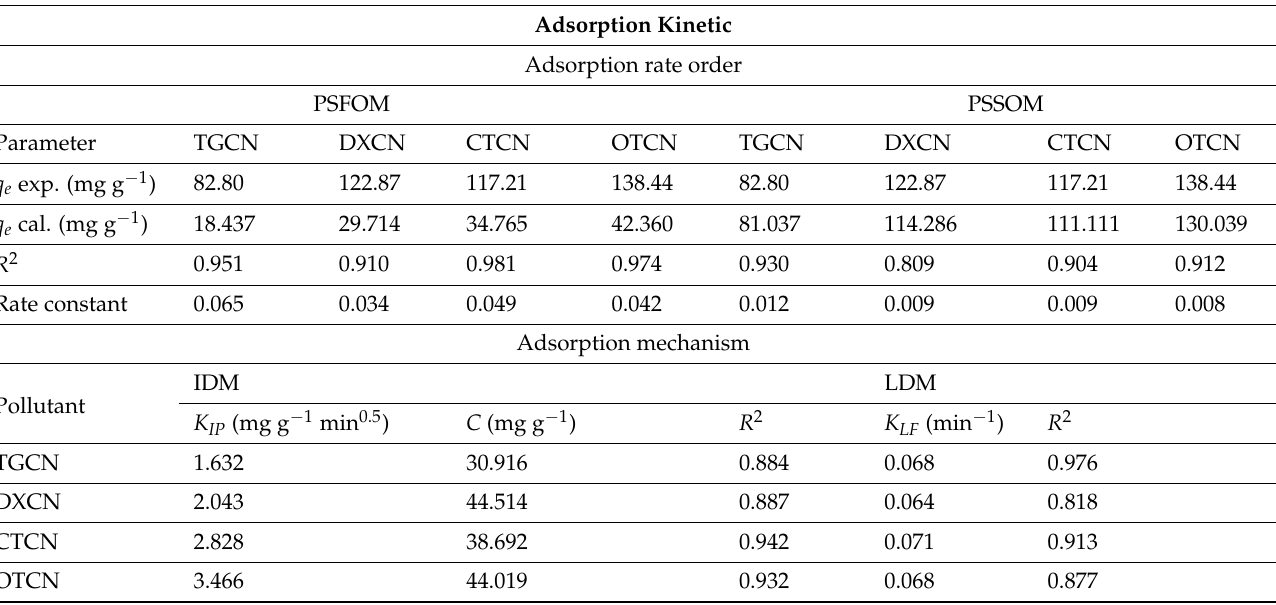
Figure 6. ( a ) PSFOM, ( b ) PSSOM ( c ) LFD, ( d ) IPD investigations for the adsorption of TGCN, DXCN, Figure 6. (a) PSFOM, (b) PSSOM (c) LFD, (d) IPD investigations for the adsorption of TGCN, DXCN, CTCN, and OTCN on the synthesized CRNPs from 100 mg L − 1 solutions at 25 ◦ C. CTCN, and OTCN on the synthesized CRNPs from 100 mg L −1 solutions at 25 °C. Table 1. The kinetic results of the adsorption of TGCN, DXCN, CTCN, and OTCN on the fabricated CRNPs from 50 mg L − 1 solutions at 25 ◦